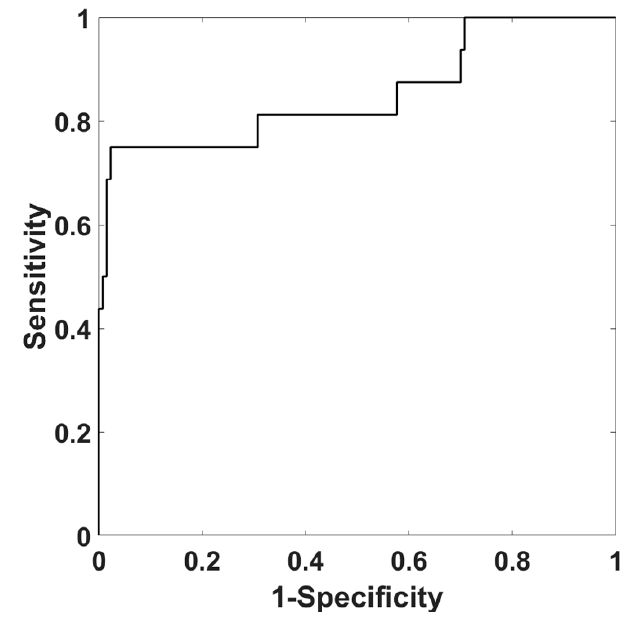
Figure 5. ROC of PPG-ABI in assessing cardiovascular risk (0.9 ≤ VE-ABI ≤ 1.4 vs. 0.9 VE-ABI < 0.9 or VE-ABI > 1.4).